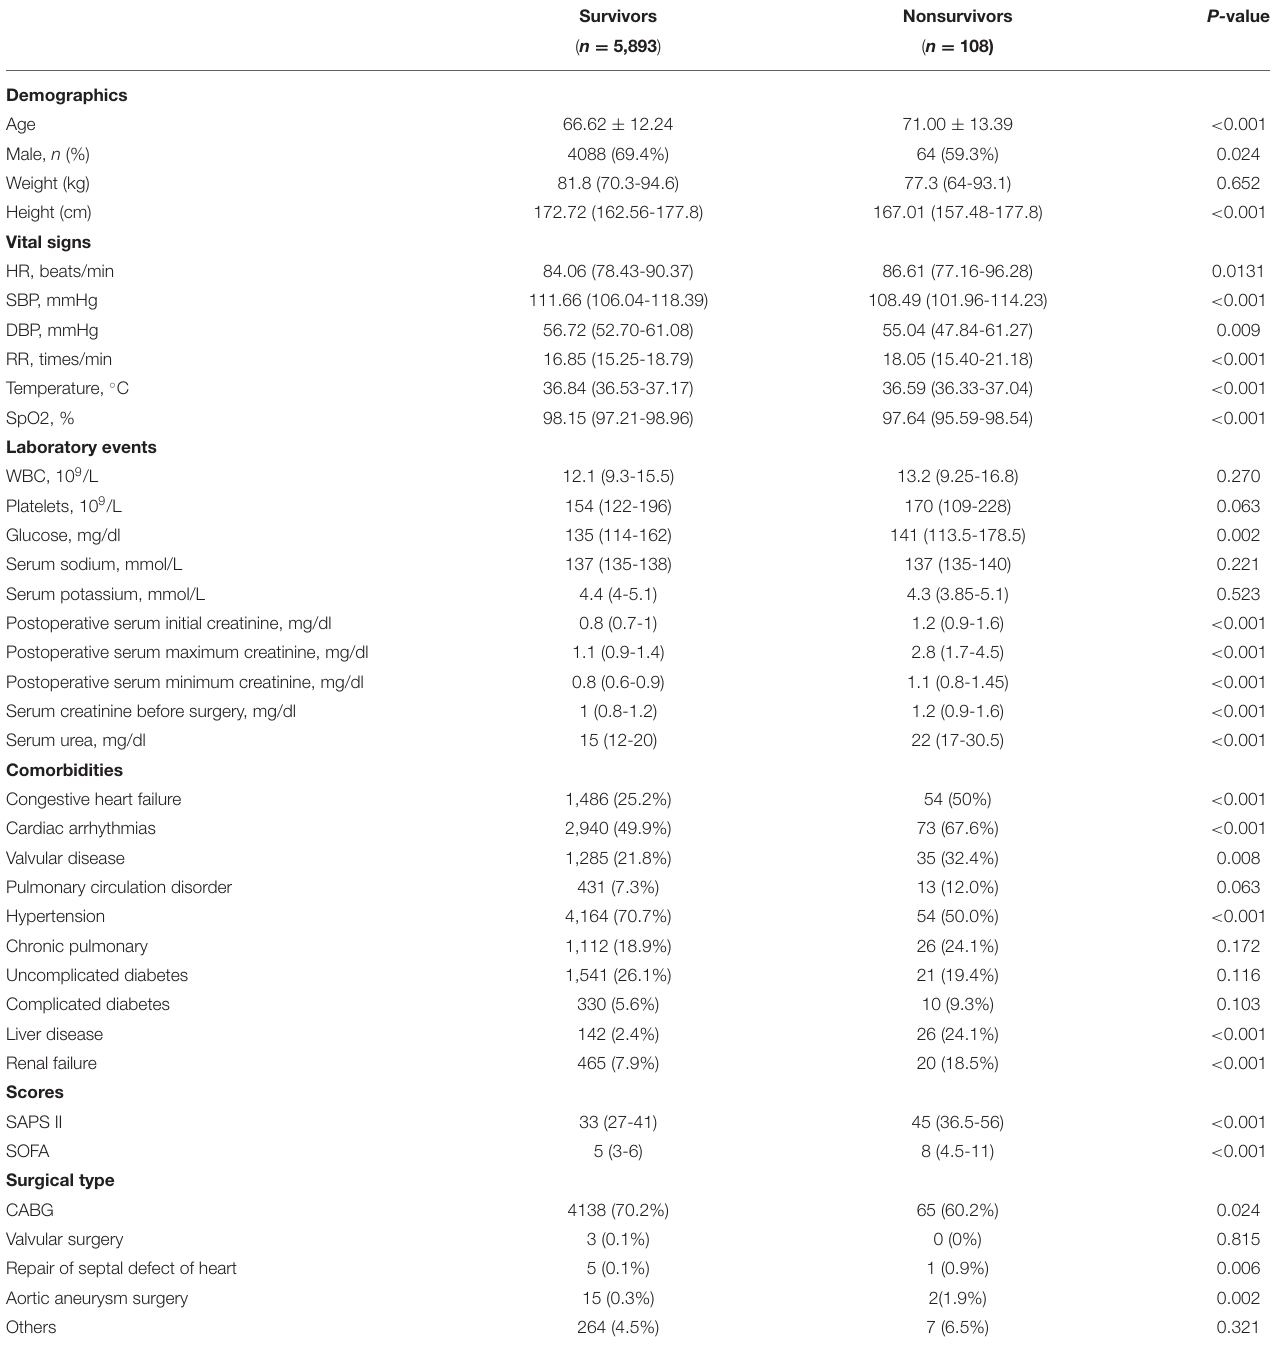
TABLE 1 | Baseline characteristics of the study population with different survival